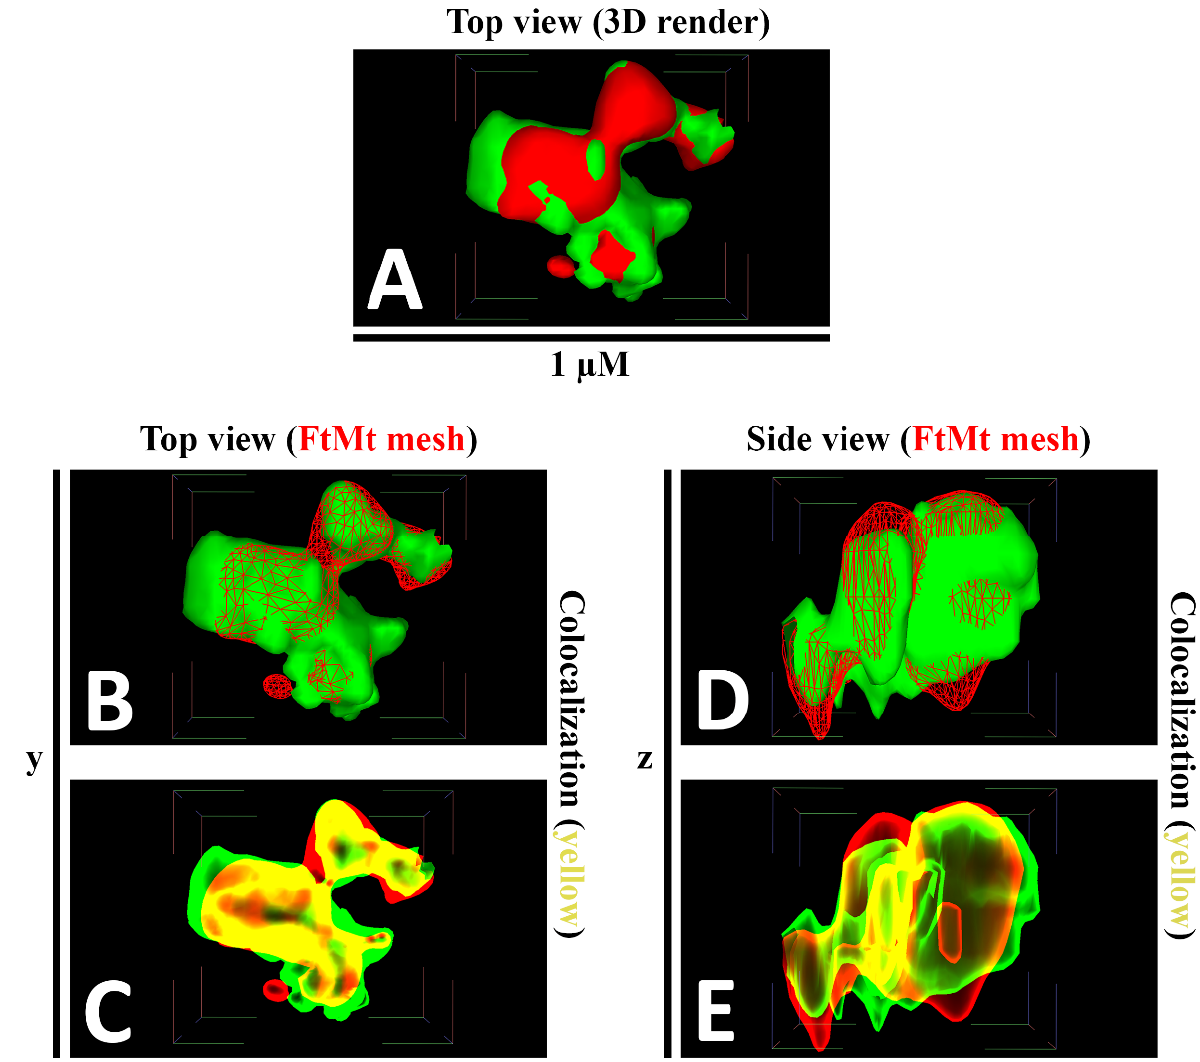
Figure 5. The FtMt and LC3 colocalization model is rendered using a shader. ( A ). Colocalization model before administrating the shader. Colocalized region was not visible as it was obstructed by the respective rendered FtMt and LC3 3D model. ( B ). Top view of FtMt and LC3 colocalization model without application of shader. FtMt signal was presented as a network/mesh while LC3 signal was presented as a solid surface. ( C ). Top view of FtMt and LC3 colocalization model with shader applied. Colocalization region between FtMt and LC3 signal was visible within the model. ( D ). Side view of FtMt and LC3 colocalization model. FtMt signal was presented as a network/mesh while LC3 signal was presented as a solid surface. ( E ). Side view of FtMt and LC3 colocalization model without application of shader. FtMt signal was presented as a network/mesh while LC3 signal was presented as a solid surface. Colocalization region between FtMt and LC3 signal was visible within the